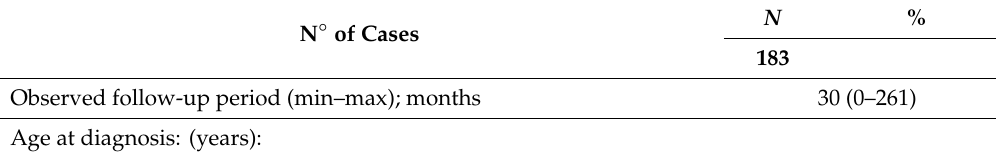
Table 1. Baseline characteristics of the 183